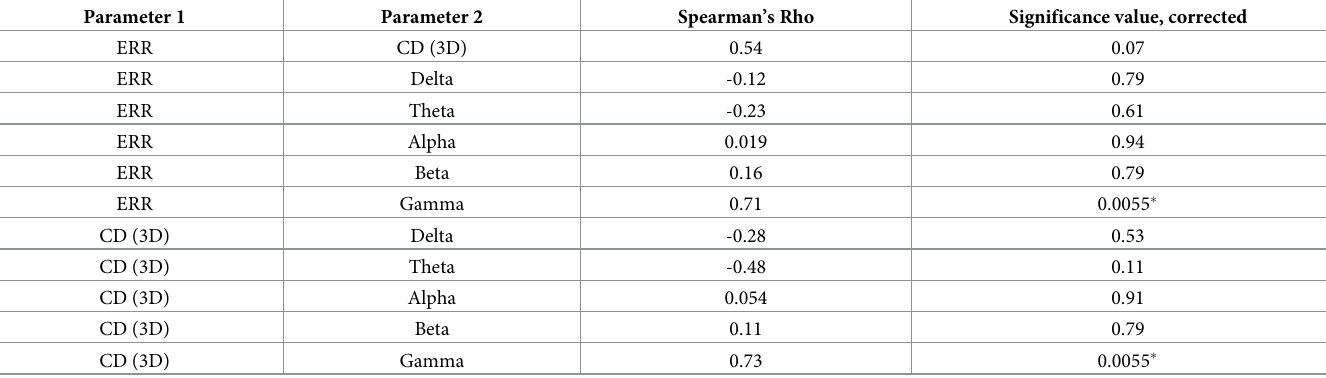
Table 4. Summary of correlations for measured changes before and after loss of response (LOR).